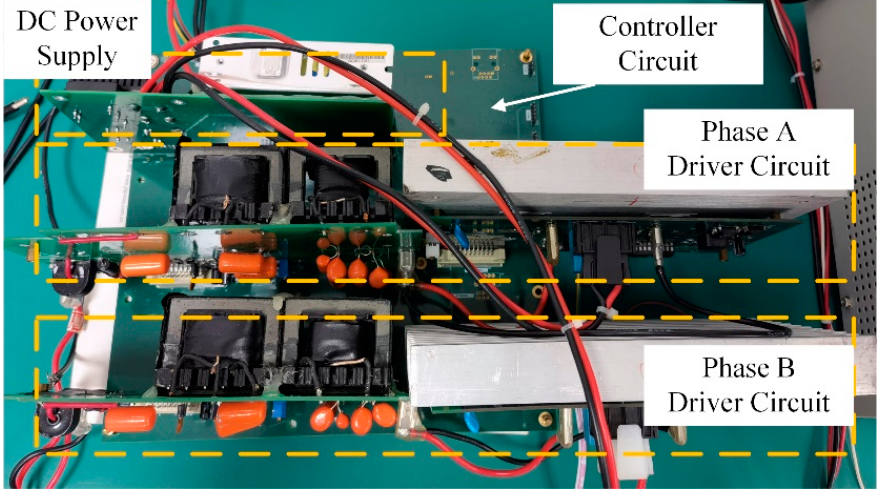
Figure 9. The self-designed drive and control circuit.